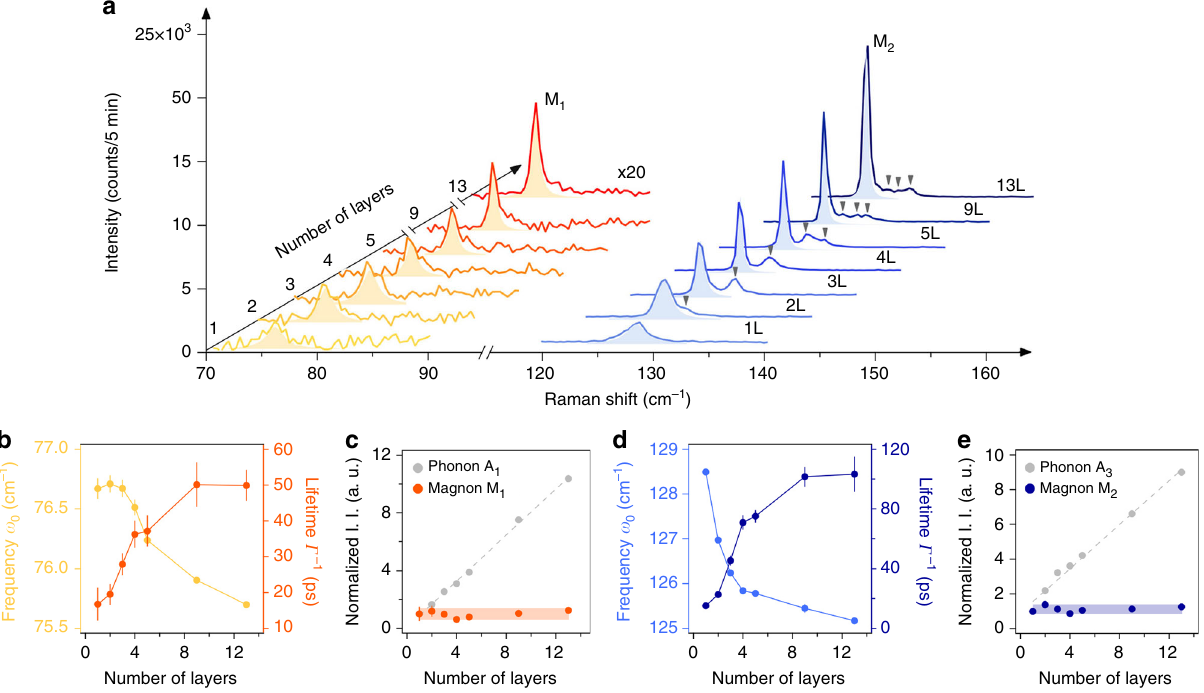
Fig. 3 Layer number dependence of the zero-momentum magnon characteristics. a Raman spectra of the M 1 (intensity multiplied by 20) and M 2 magnons for 1 – 5 L, 9 L, and 13 L samples. Light yellow and blue shaded areas are the Lorentzian fi ts for the M 1 and M 2 magnon modes, respectively. The gray triangles highlight the satellite magnon peaks. b Frequency ( ω 0 , left axis) and lifetime ( Γ – 1 , right axis) of the M 1 magnon as a function of layer number. c I. I. of the M 1 magnon as a function of layer number with I. I. of the A 1 phonon shown in gray for comparison. d , e Plots for M 2 that are similar to b , c , with I. I. of the A 3 phonon plotted in gray in e for comparison. Error bars in b – e represent the two SEs of fi tting parameters in the Lorentzian fi ts to individual Raman spectra at different